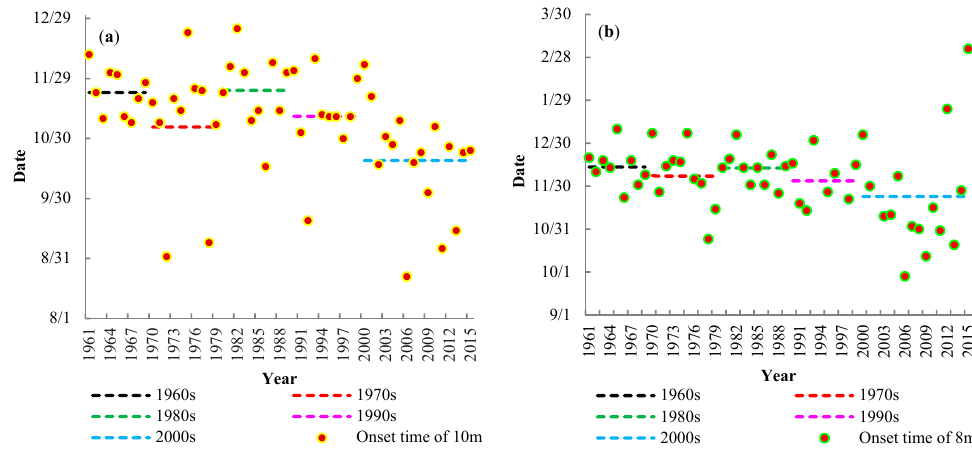
Figure 6. Onset times of 10 m and 8 m during 1961–2015 at Xingzi station. ( a ) 10 m; ( b ) 8 m.